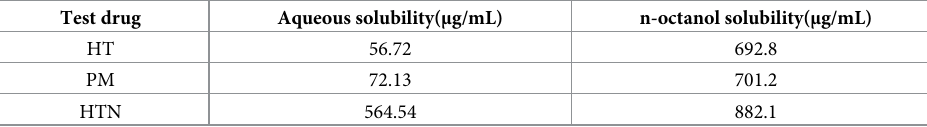
Table 6. Apparent solubility studies of HT, PM, and HTN.